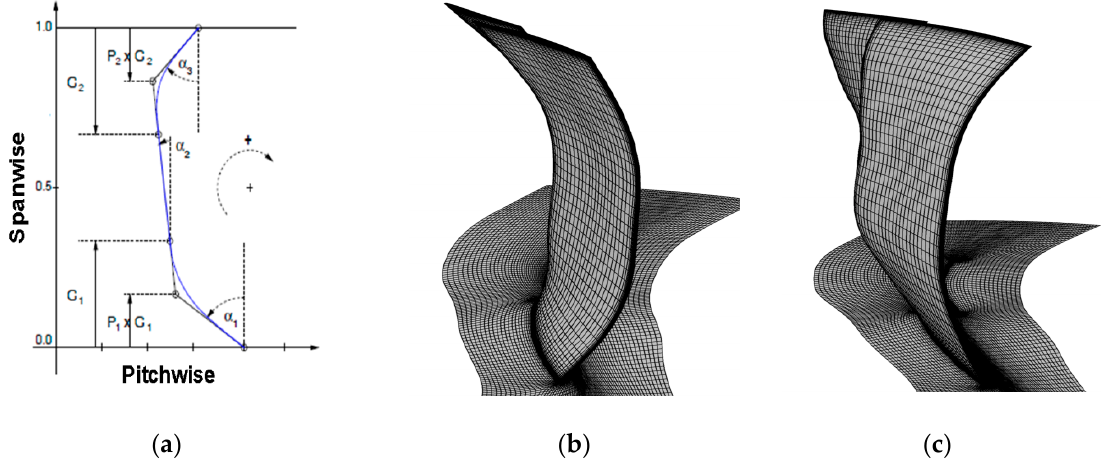
Figure 6. Design method of bow blade and computational grids of two kinds of bow blades. ( a ) design method of bow blade. ( b ) positive blade at 30°. ( c ) negative blade at 30°.